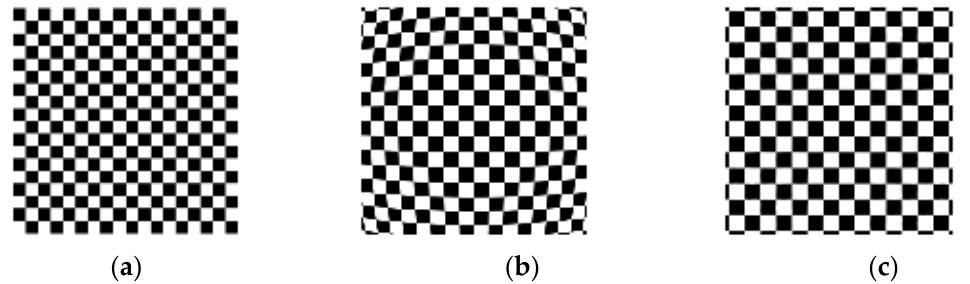
Figure 10. ( a ) checkerboard image; ( b ) checkerboard image obtained by simulating lens distortion; ( c ) refer to the isophase search method and resampling rules to obtain the corrected image.